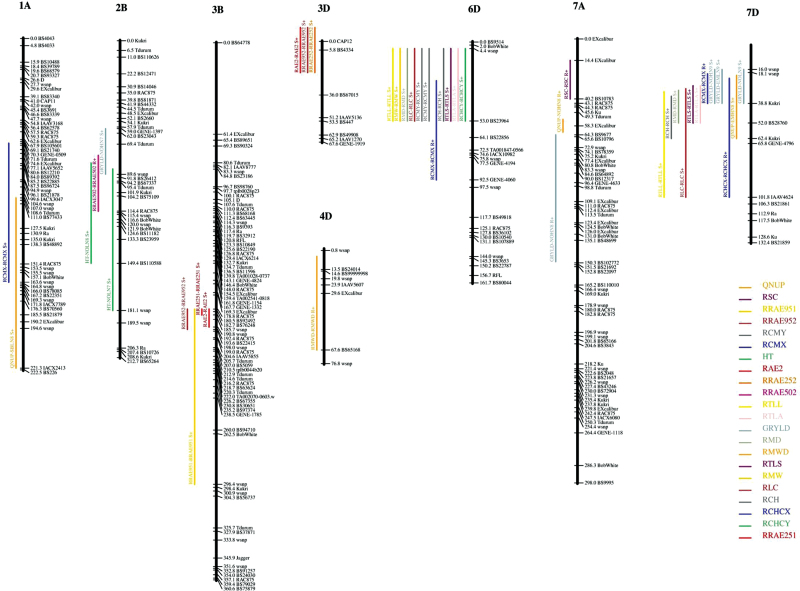
Diagrams of eight wheat chromosomes (1A, 2B, 3B, 3D, 4D, 6D, 7A, 7D) with QTL locations. Chromosomes are depicted in black; a selection of markers from the iSelect Savannah × Rialto map and their mapping positions are shown to the right of the chromosomes. Only chromosomes that carry a seedling root QTL are shown. QTL confidence intervals are shown as vertical bars to the left of the chromosomes; bar colours are specific for traits as defined in the key. Trait names and environments are shown above each bar. S+, positive effect comes from Savannah; R+, positive effect from Rialto.